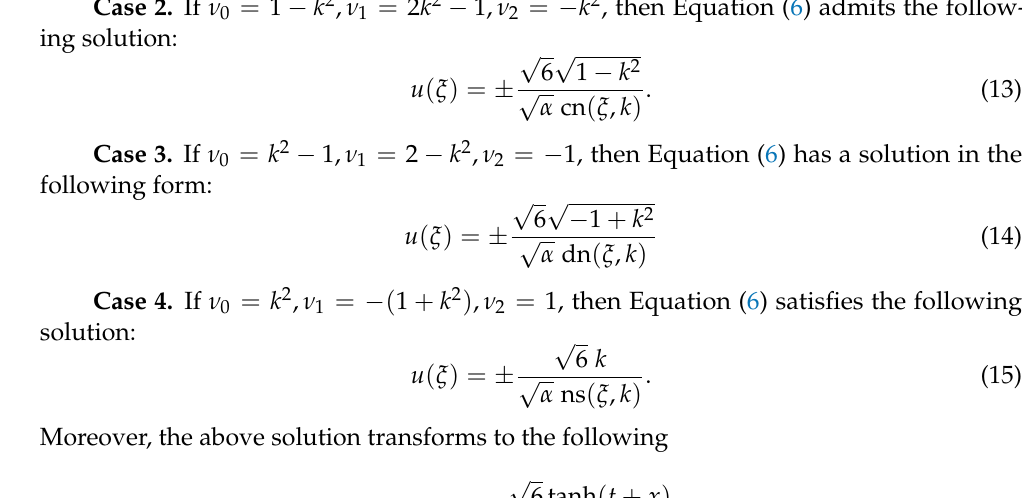
Figure 1. The graphs ( a , b ) are the 3D plots of the positive solutions (11), (12), respectively. In ( a ), k =